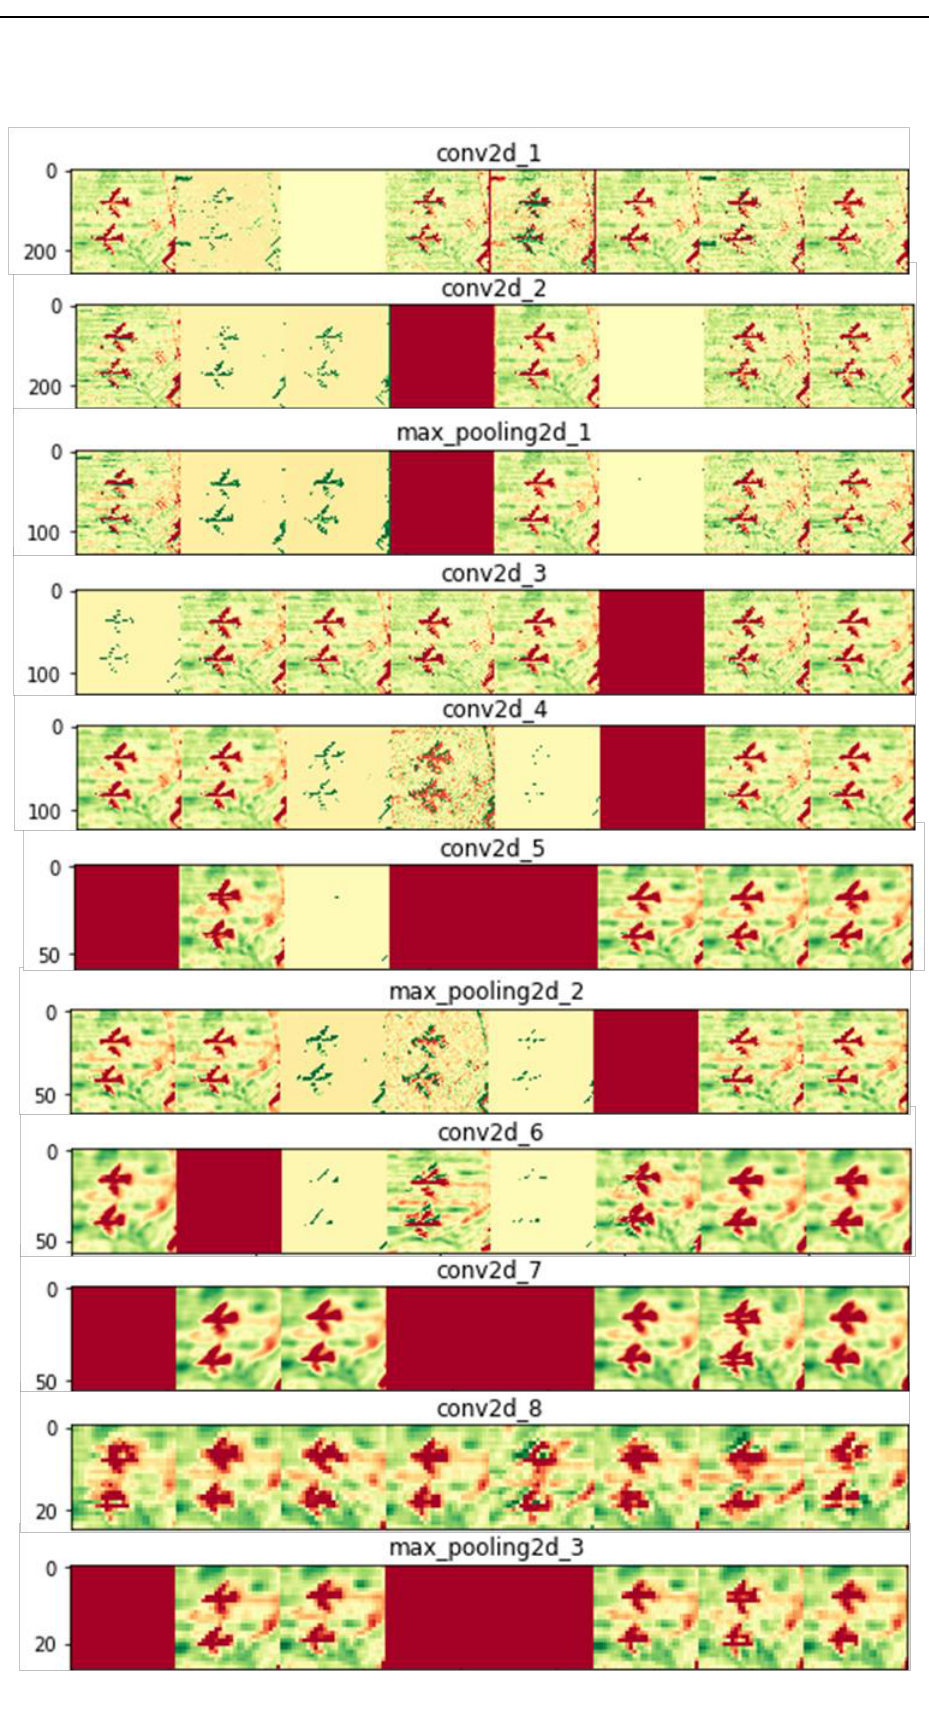
Figure 4. Feature visualization of optimized RSISC-16 Net